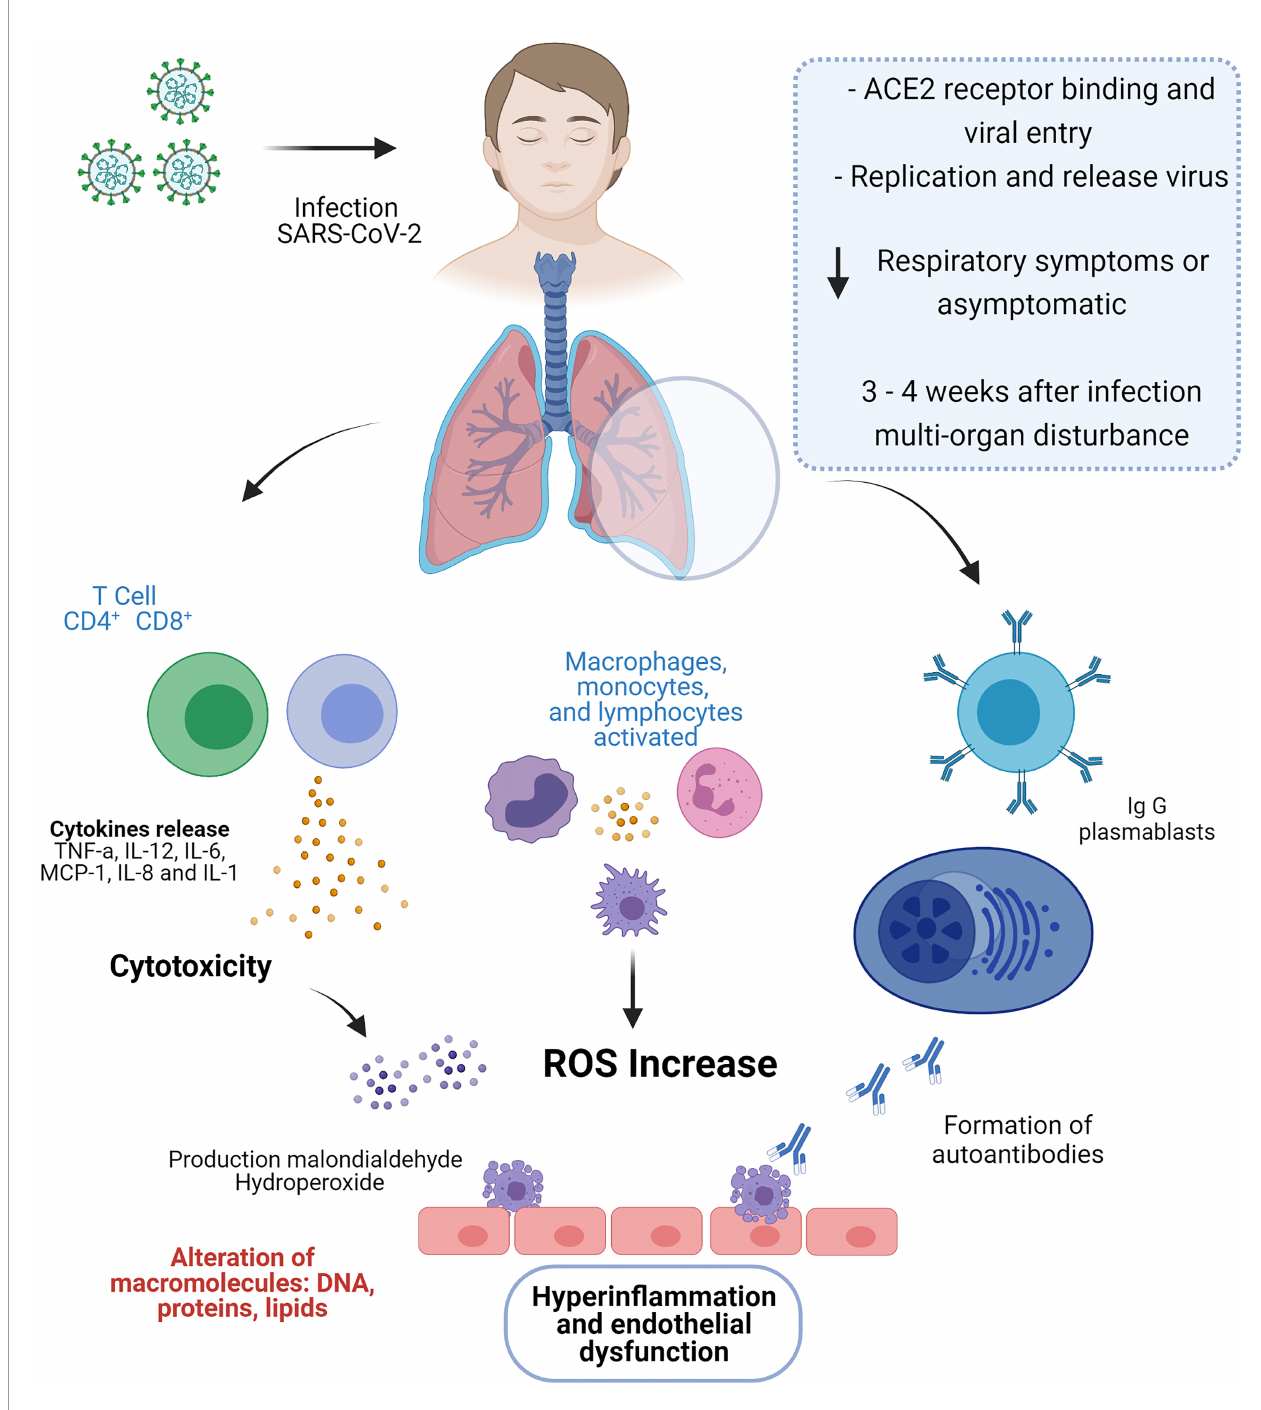
FIGURE 2 | In SARS-CoV-2 infection, the binding of the receptor ACE2 with the virus leads to entry into the host cell and its subsequent replication and release. During the active phase of COVID-19, MIS-C patients were asymptomatic or with mild respiratory symptoms; however, three to four weeks after exposure to SARS- CoV-2, children develop a multi-organ disturbance. MIS-C is characterized by strong activation of T lymphocytes leading to the release of a cytokine storm and increased cytotoxic activity. Furthermore, T cells, together with monocytes and macrophages, promote oxidative stress by increasing reactive oxygen species, which alter macromolecules such as DNA, proteins and lipids. Additionally, the presence of autoantibodies that recognize endothelial cells, promoting damage and contributing to endothelial dysfunction and multisystem in fl ammation typical of MIS-C. Figure created with BioRender,